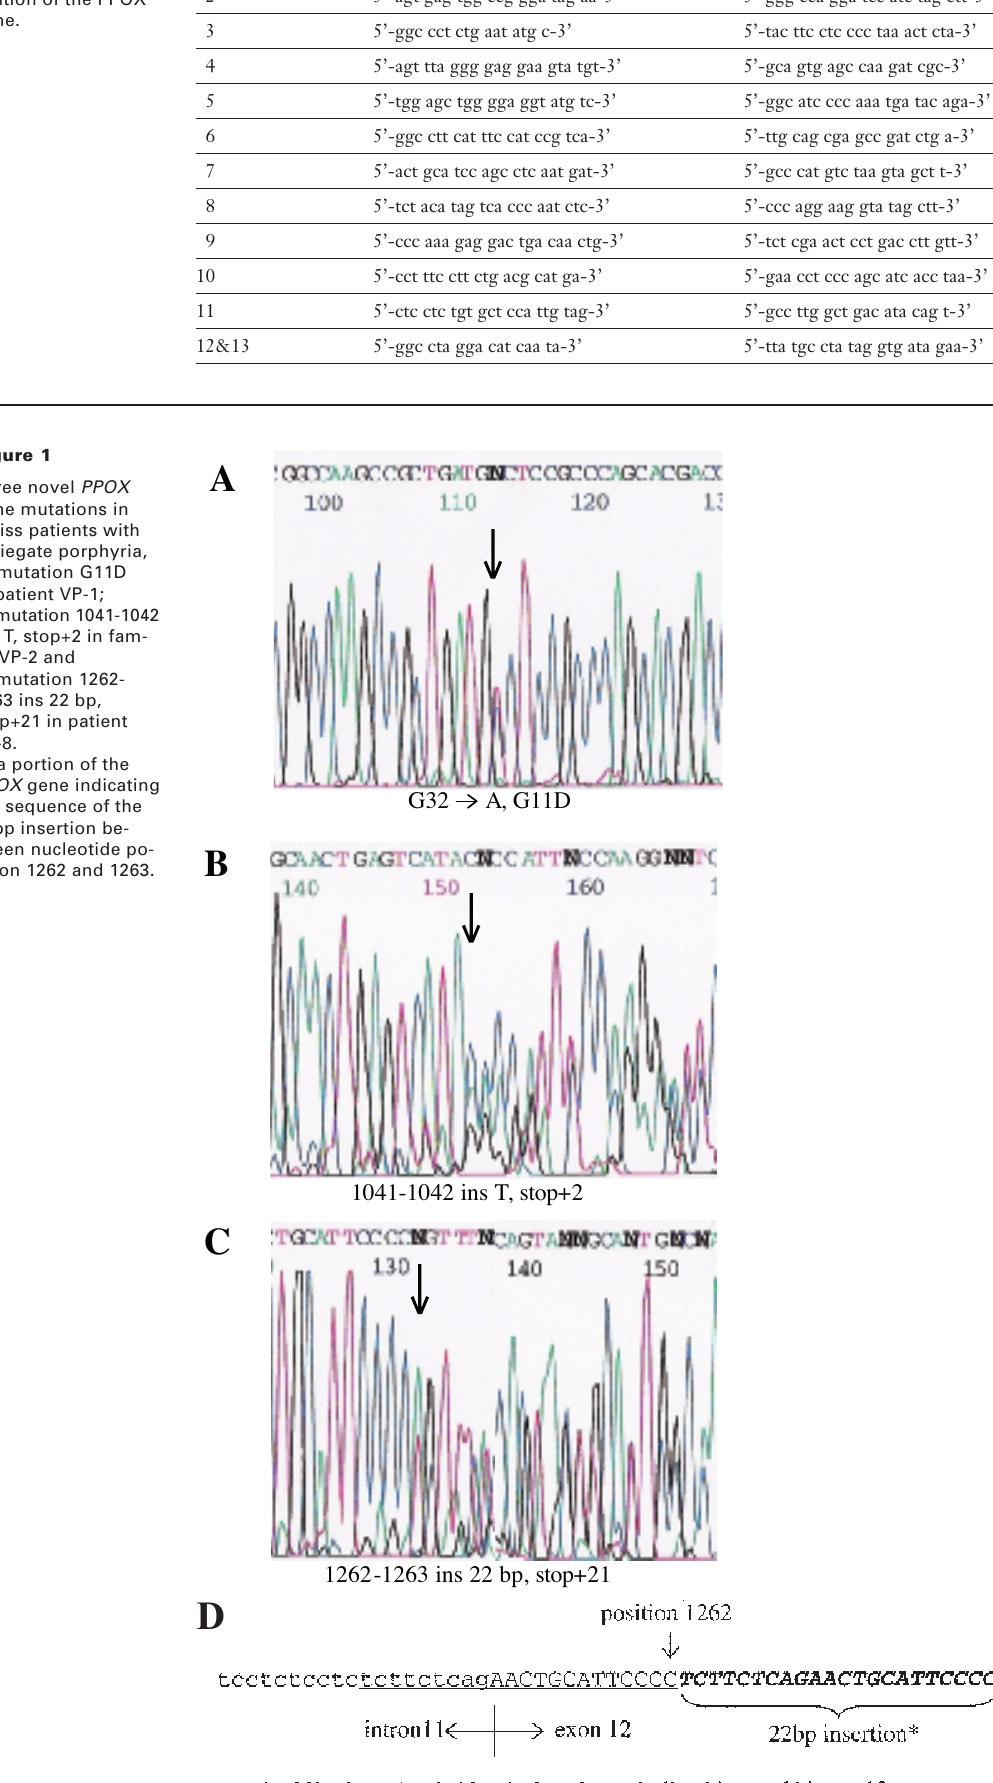
Primer sequences used for PCR-ampli- fication of the PPOX gene.